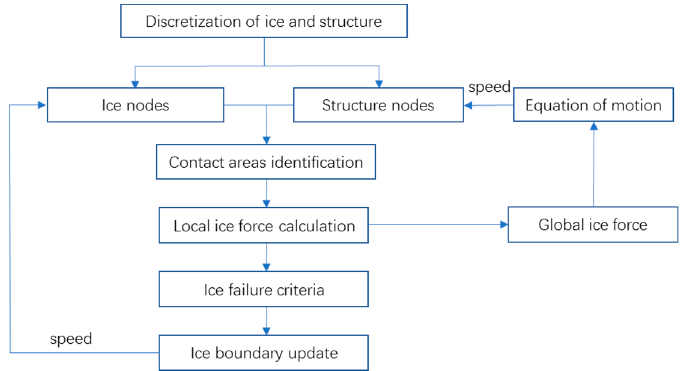
Figure 2. Loop of ice crushing force calculation.